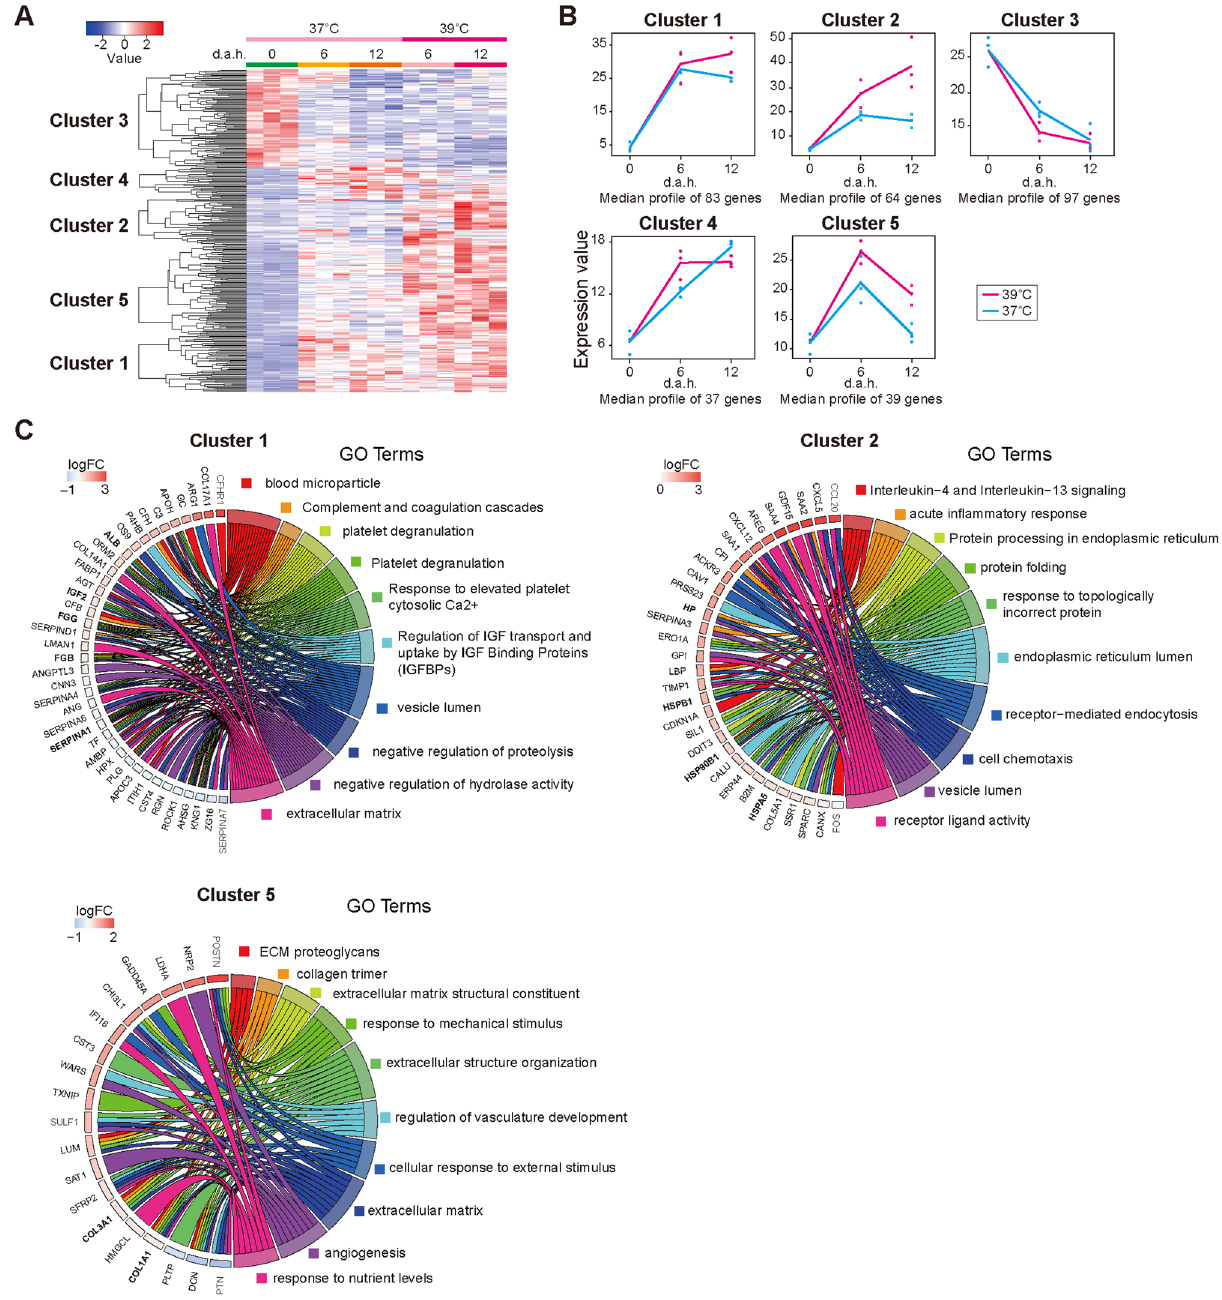
Figure 4. Global transcriptional analysis to identify the specific gene signatures in hESC-HLCs with heat treatments at 37 °C and 39 °C. ( A ) Hierarchical clustering and heat map of the differentially expressed genes in hESC-HLCs with heat treatments at 37 °C and 39 °C. ( B ) Typical plots of five clusters identified in ( A ). Each dot represents the median of expression values of each sample. ( C ) Chord diagram presenting enriched GO clusters for the differentially expressed genes hESC-HLCs with heat treatment at 37 °C and 39 °C. In each chord diagram, enriched GO clusters are shown (right), and genes contributing to this enrichment shown (left). Each cluster was found in ( A